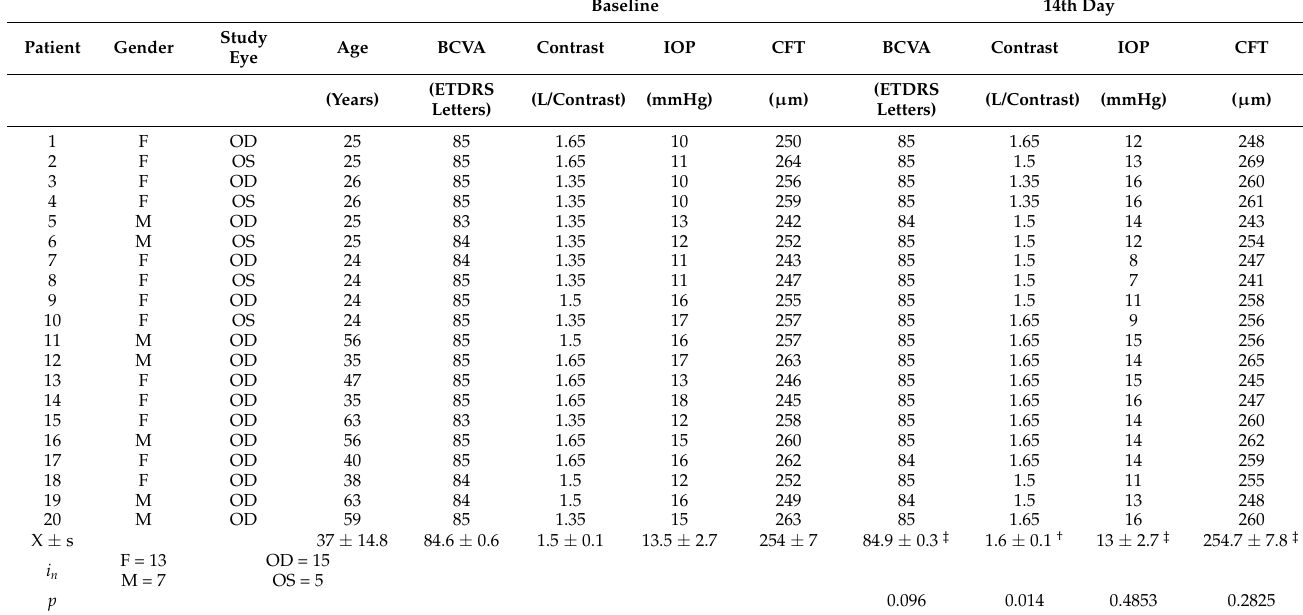
Table 2. Demographics and clinical characteristics of healthy subjects treated with triamcinolone acetonide-loaded liposomes formulation. BCVA, best corrected visual acuity; CFT, central foveal thickness; ETDRS, Early Treatment Diabetic Retinopathy Study; IOP, intraocular pressure; OD, right eye; OS, left eye. Baseline 14th Day